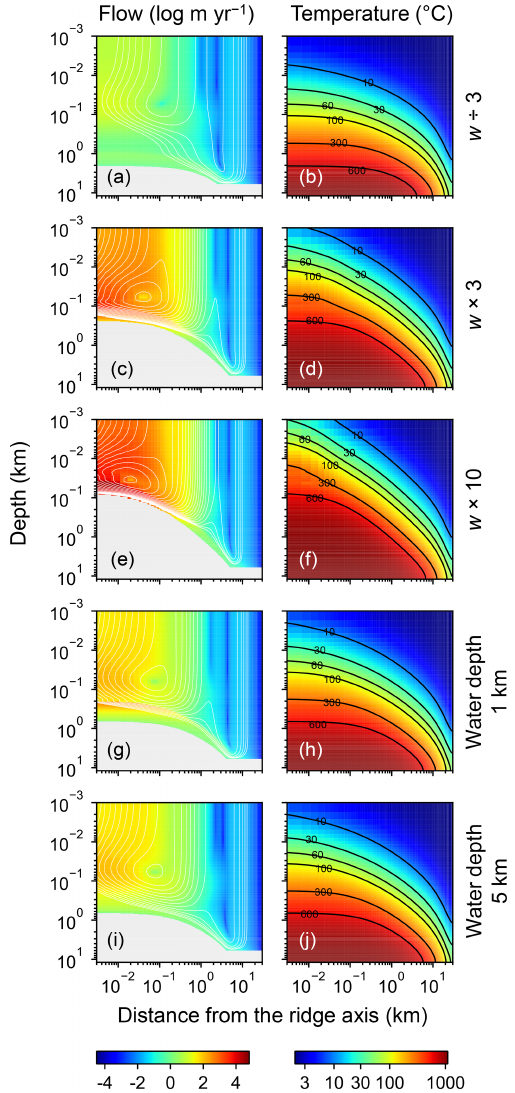
Figure 7. Two-dimensional distributions of hydrothermal fluid flow (a, c, e, g, and i) and temperature (b, d, f, h, and j) from simulations with different spreading rates and ocean depths. Logarithms of fluid velocity and mass-based stream lines are depicted in (a, c, e, g, and i) . The panels in the first three rows assume different spreading rates (1 × 10 − 2 myr − 1 in a and b , 9 × 10 − 2 myr − 1 in c and d , and 30 × 10 − 2 myr − 1 in e and f ), while those in the last two rows assume different ocean depths (1km in g and h ; 5km in i and j ). Values of other parameters are the same as those in the standard simulation (e.g., Fig. 1). See the caption of Fig. 1 for the explanation of gray zones in (a, c, e, g, and i) .